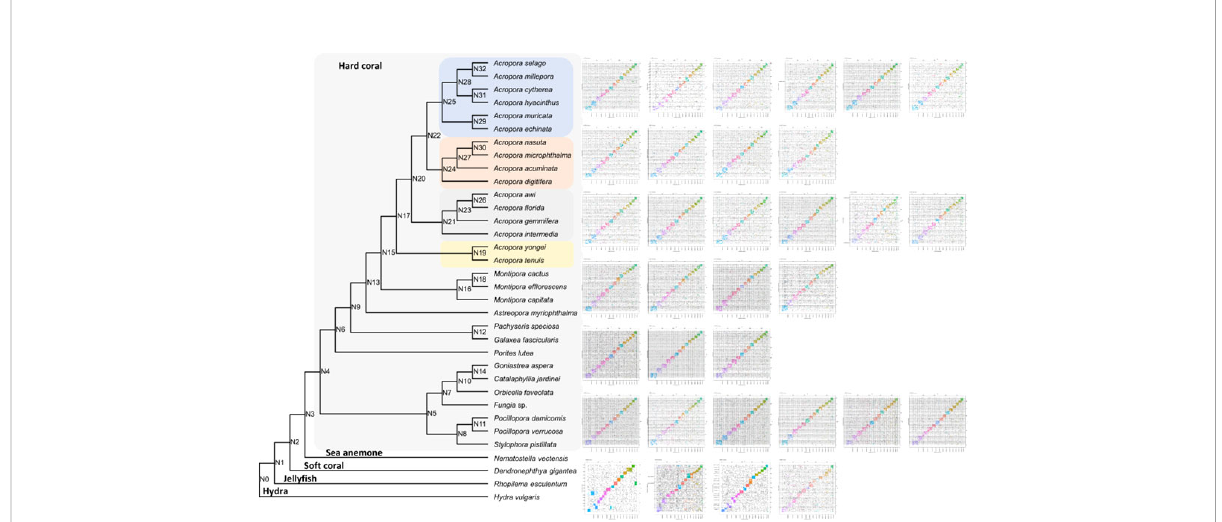
FIGURE 2 Oxford synteny plot of orthologous genes between Catalaphyllia jardinei and other 33 cnidarians. The divergence tree was constructed based on the concatenated alignment of single-copy orthogroups. Supporting values were inferred from STAG algorithm, and all were equal to 1 except that N26 = 0.583 and N28 = 0.713. Subplots were listed from left to right according to the top to bottom order of the phylogenetic tree